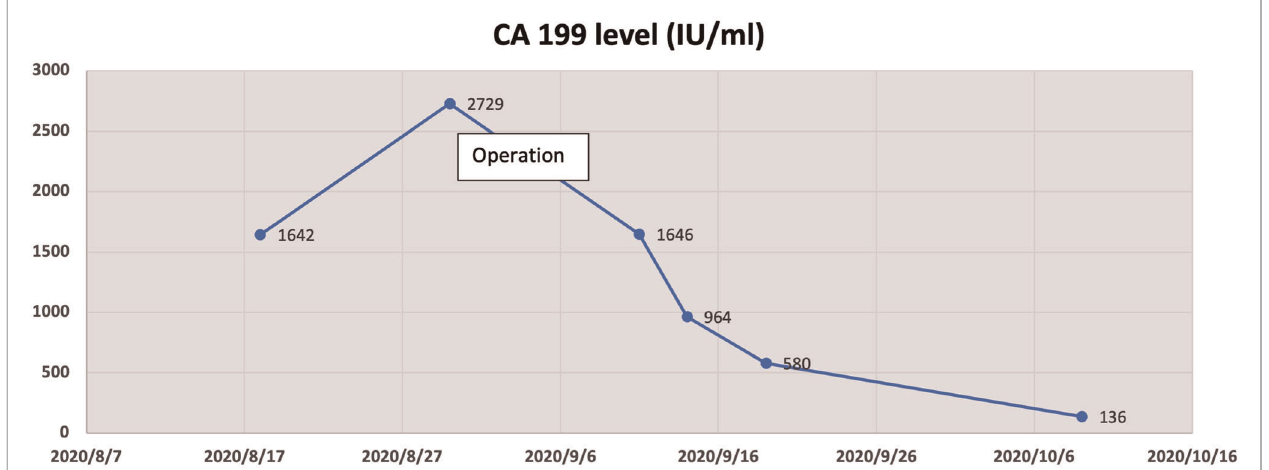
FIGURE 4 | The change graph of the Ca199 value showed that it gradually decreased after operation, suggesting a correlation between elevated CA199 and cervical